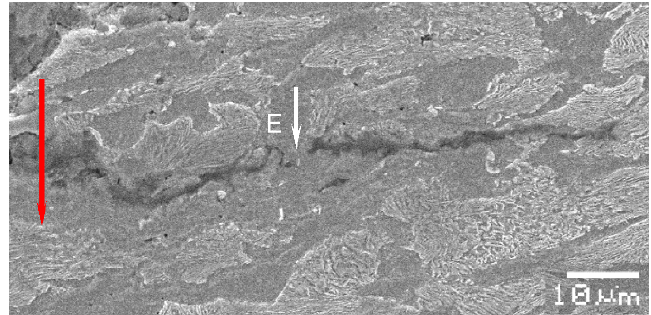
Figure 10. Microstructural damage for strain level ε z 4 = 1.59: ( a ) submicroscopic particles of lamellar cementite; ( b ) nucleation of microcracks in the central zone of the sample; ( c ) microcracks in the peripheral zone of the sample (×5000 magnification, red arrow—direction of upsetting).